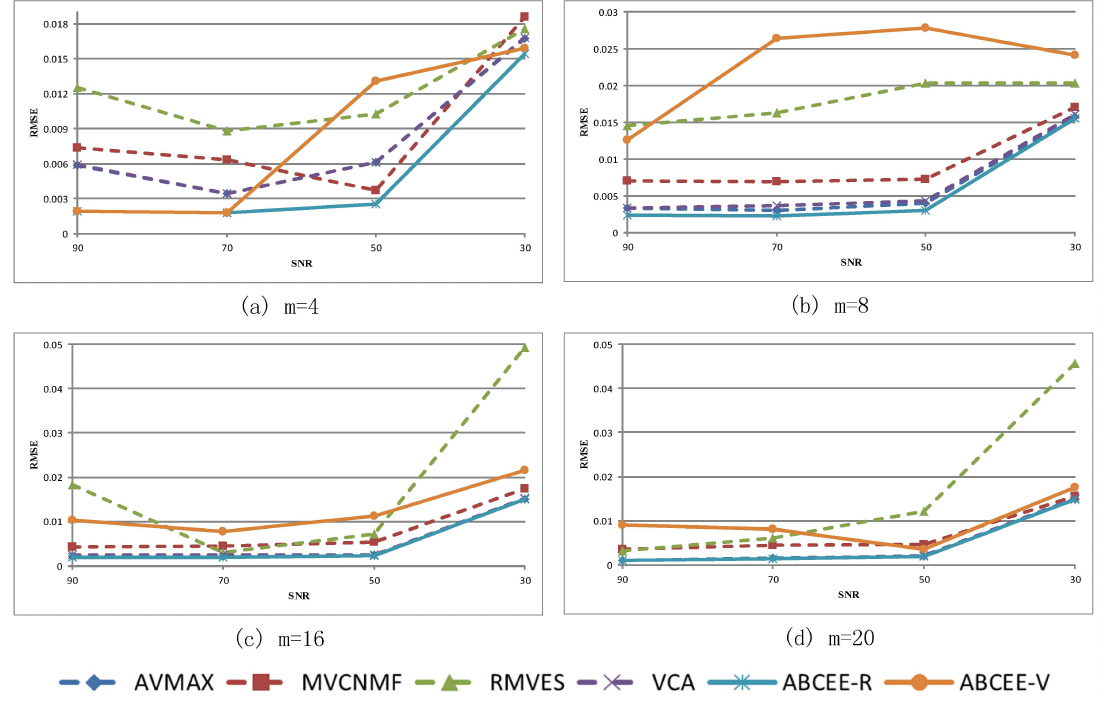
Figure 5. RMSEs for synthetic Dataset 2. ( a ) m=4; ( b ) m=8; ( c ) m=16; ( d )